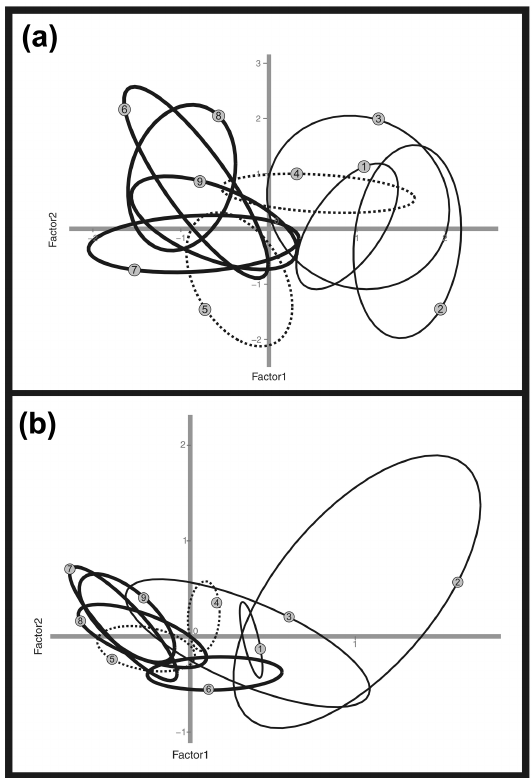
Figure 1. Contour plots showing the 75% confidence region of the relationships among the analysed individuals per breed. (a) shows the information provided by the principal component analysis car- ried out on body measurements: Factor 1, on the x axis explained 59.0% of the total variance while Factor 2, on the y axis explained 8.0% of the total variance. (b) shows the information provided by the correspondence analysis carried out on qualitative traits: dimen- sion 1, on the x axis explained 26.2% of the total variance while dimension 2, on the y axis explained 15.5% of the total variance. Thin-line contours correspond to zebu breeds; dotted-line contours correspond to sanga breeds; and thick-line contours correspond to taurine breeds. Numbers on contours are consistent with